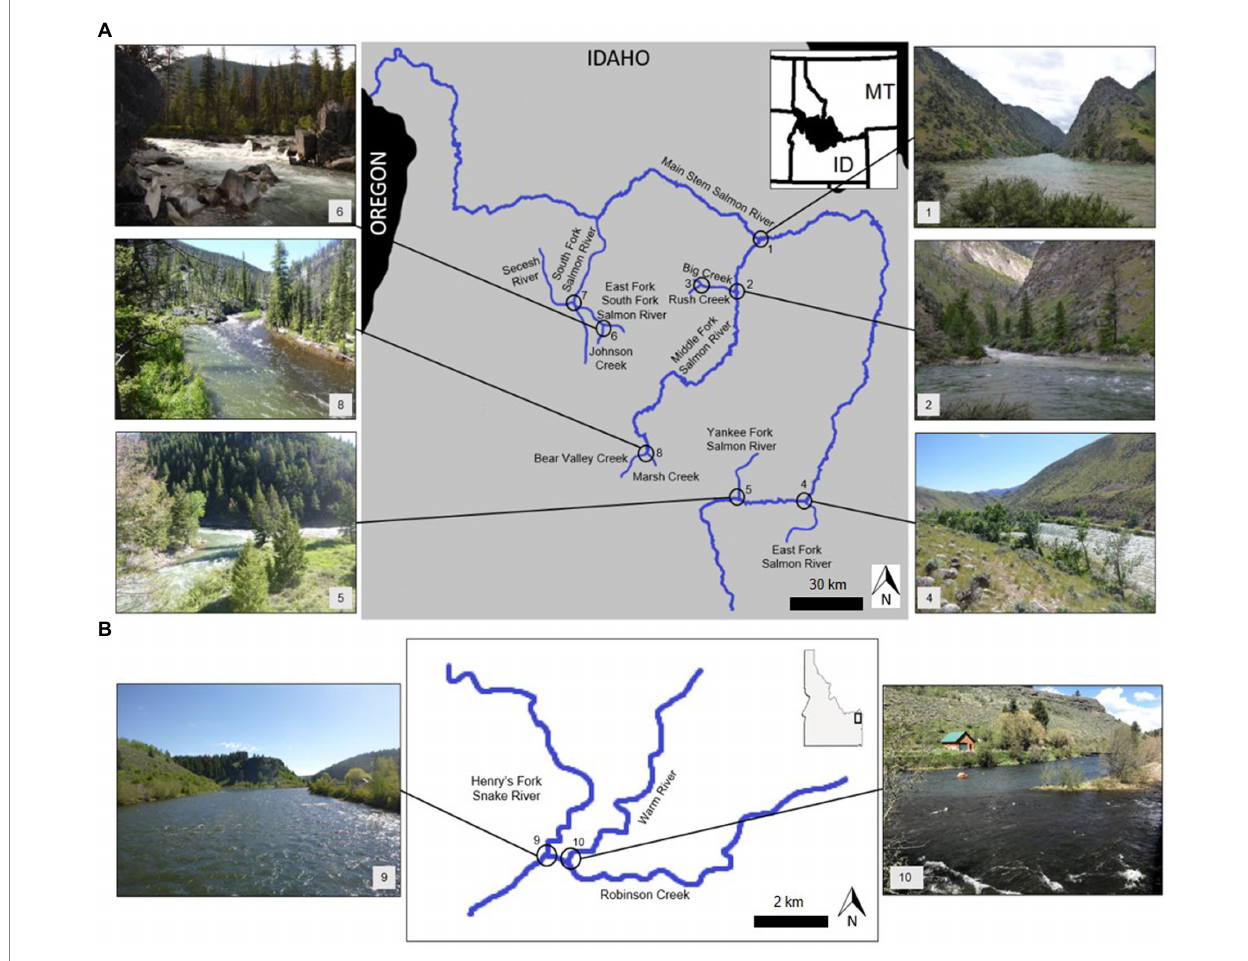
FIGURE 2 (A) Map of the study confluences, indicated by numbers 1–8, in the Salmon River Basin, Idaho, United States, which were surveyed in summer 2018. (B) Map of the study confluences, indicated by numbers 9–10, in the Henry’s Fork of the Snake River, Idaho, United States which were surveyed in summer